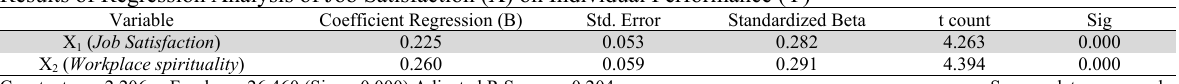
Results of Regression Analysis of Job Satisfaction (X) on Individual Performance (Y) Variable